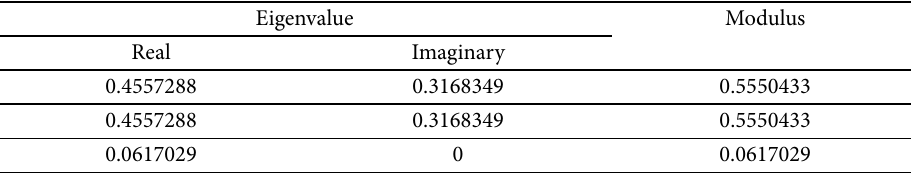
Table 4. Eigen value stability